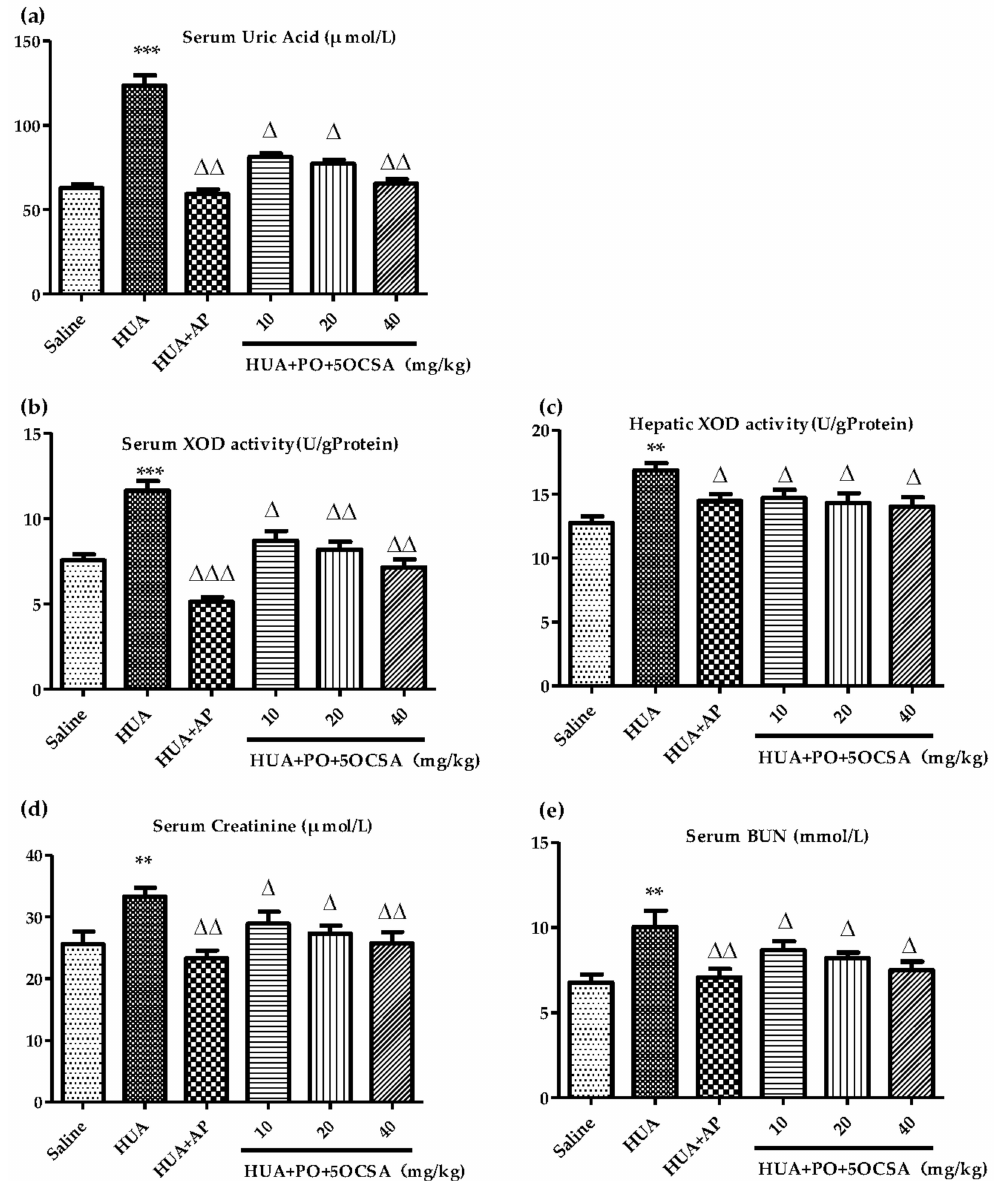
Figure 4. Effects of 5OCSA on sUA, XOD and markers of kidney damage in HUA. ( a ) Serum level of uric acid ( µ mol/L). ( b ) Serum XOD activity (U/g Protein). ( c ) Hepatic XOD activity (U/g Protein). ( d ) Serum creatinine ( µ mol/L). ( e ) Serum BUN (mmol/L). ** p < 0.01, *** p < 0.005, compared with saline group; ∆ p < 0.05; ∆∆ p < 0.01, ∆∆∆ p < 0.005, compared with HUA group. sUA: serum uric acid; XOD: xanthine oxidase; BUN: blood urea